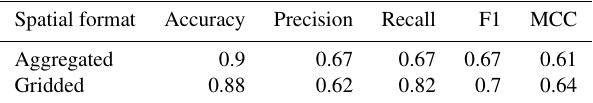
Table C1. Comparison of the random forest model performance between spatially aggregated data over the region studied and the gridded spatial format, considering all grid points.